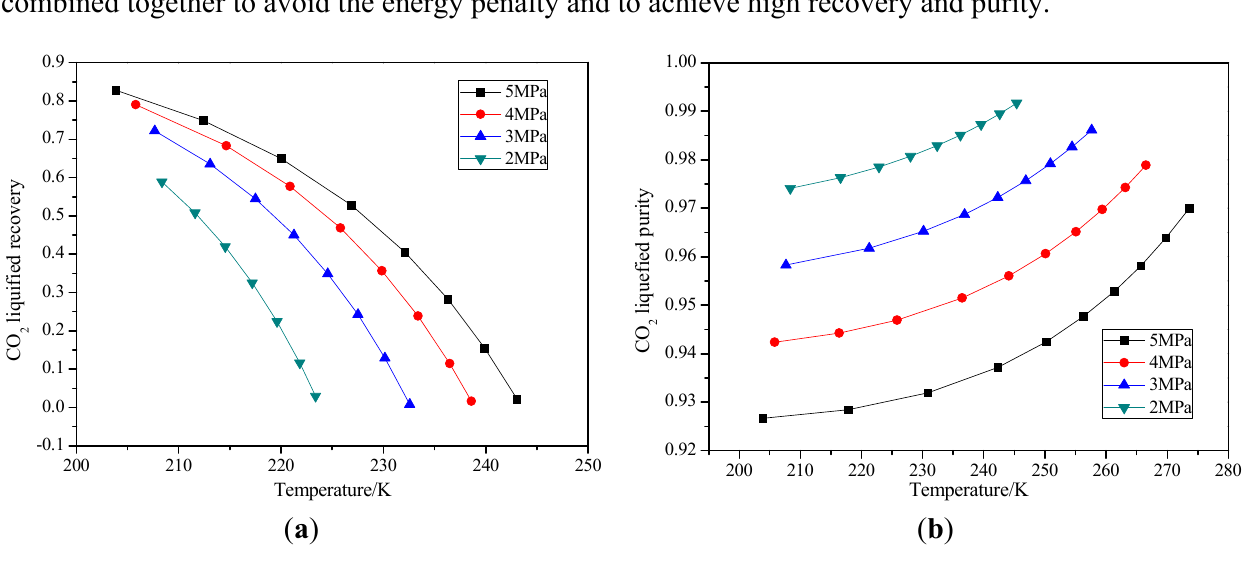
Figure 5. ( a ) Recovery of liquid CO 2 at different conditions; and ( b ) purity of liquid CO 2 at different